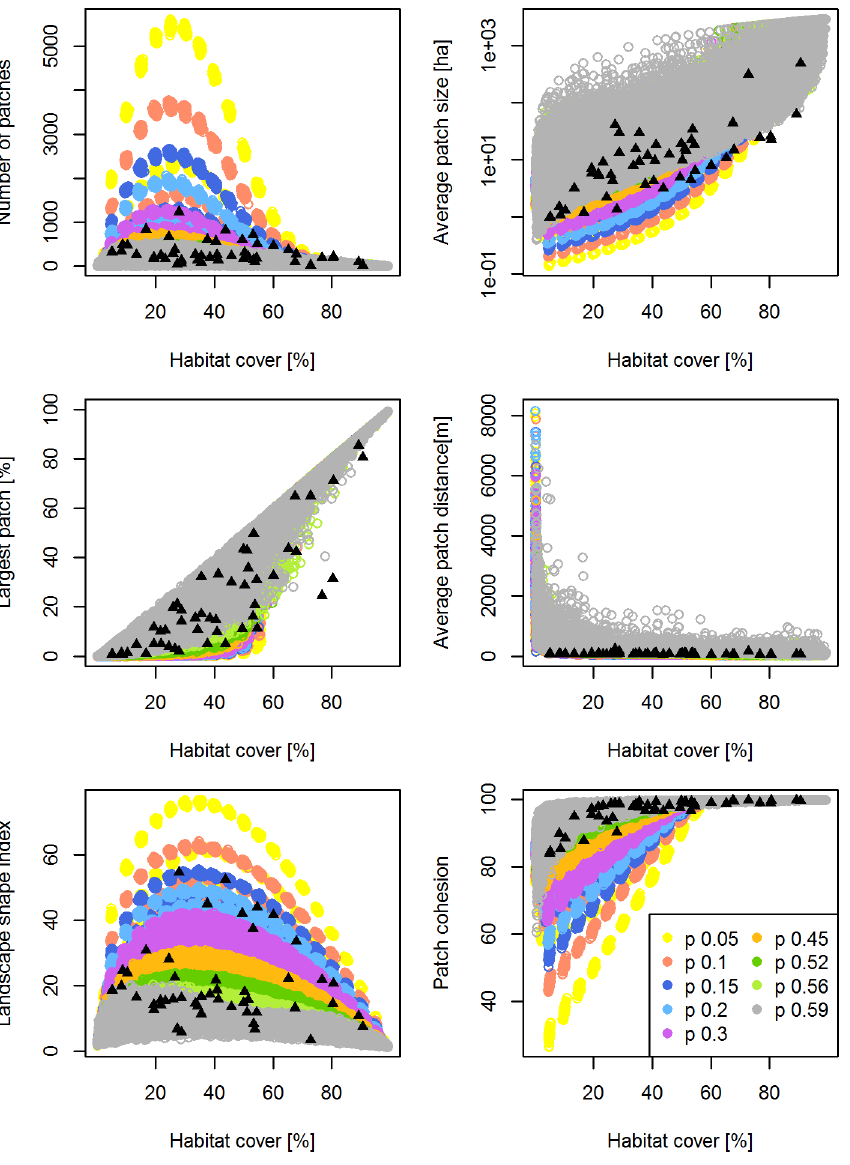
Figure 4. Range of attributes of the landscapes generated by Simmap . Generated landscapes are illustrated in colored circles, and compared to 50 real landscape maps as in Figure 2. Colors represent values of the parameter P , the parameter that controls the degree of fragmentation of the obtained patterns.